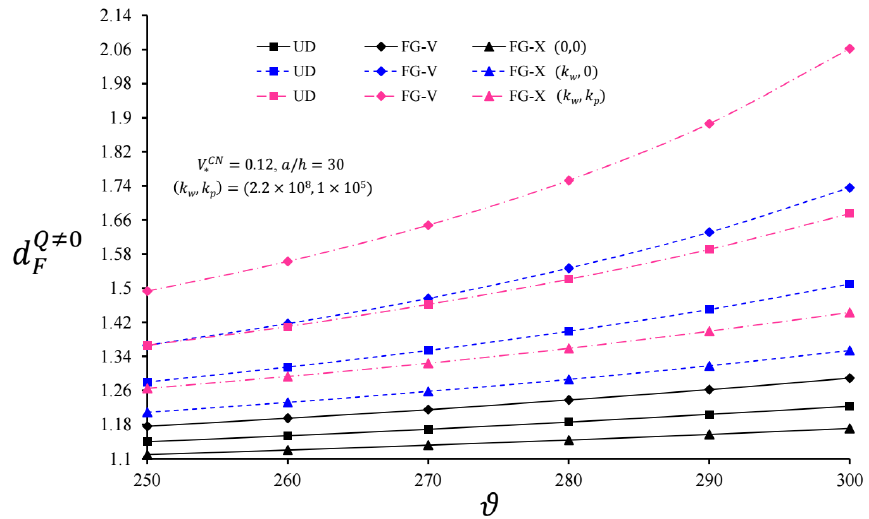
≠ Q d for infinite length CNT-based cylindrical pipes with and without EFs versus ϑ for CN Figure 4. Variation in 0 Figure 4. Variation in d Q (cid:54) = 0 for infinite length CNT-based cylindrical pipes with and without EFs F F = 0.12 and = 30 a h . versus ϑ for V CN ∗ = 0.12 and a = 30